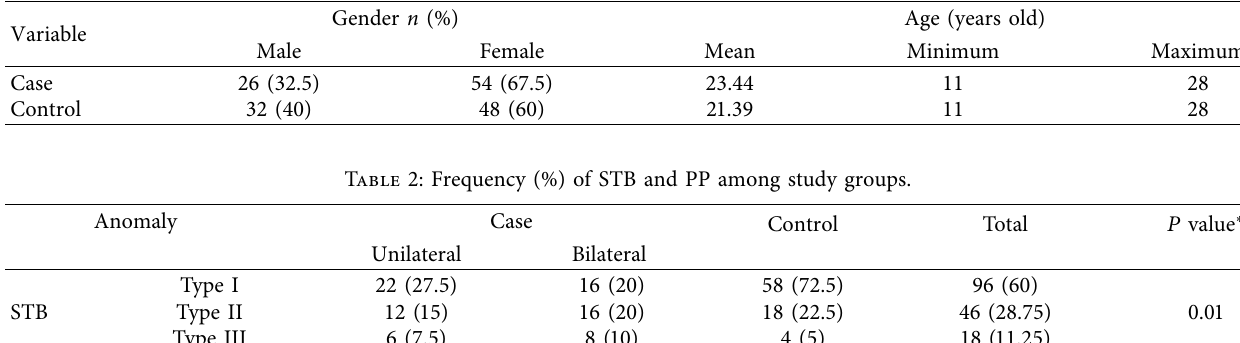
Figure 3: The classification of PP: (a) no bone emergence, (b) a partial bony emergence, and (c) a full bony bridge. Table 1: Age and gender distribution of study samples.